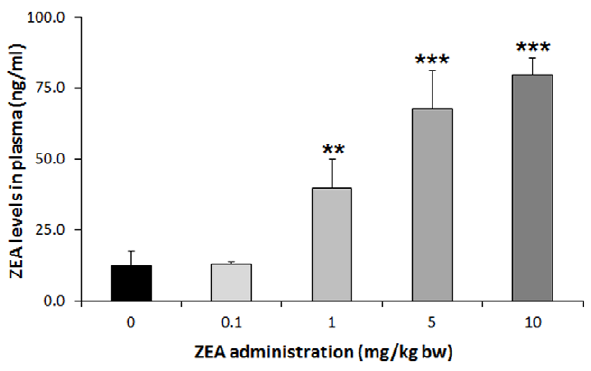
Figure 2. Blood plasma ZEA concentrations in Experiment 1 . Blood plasma ZEA concentrations in female immature rats after 3-day exposure to different dosage of ZEA (0.1–10 mg/kg bw) was measured by competitive fluorescent-microsphere based immunoassay (CFIA). The results show that there was a dose dependent increase in plasma ZEA concentration following oral administration. Blood plasma levels showed a strong positive correlation (R =0.919186) with uterus weight in a dose dependent manner. (**) Significantly different from control (p , 0.001) (n=6–7). (***) Significantly different from control (p , 0.001)